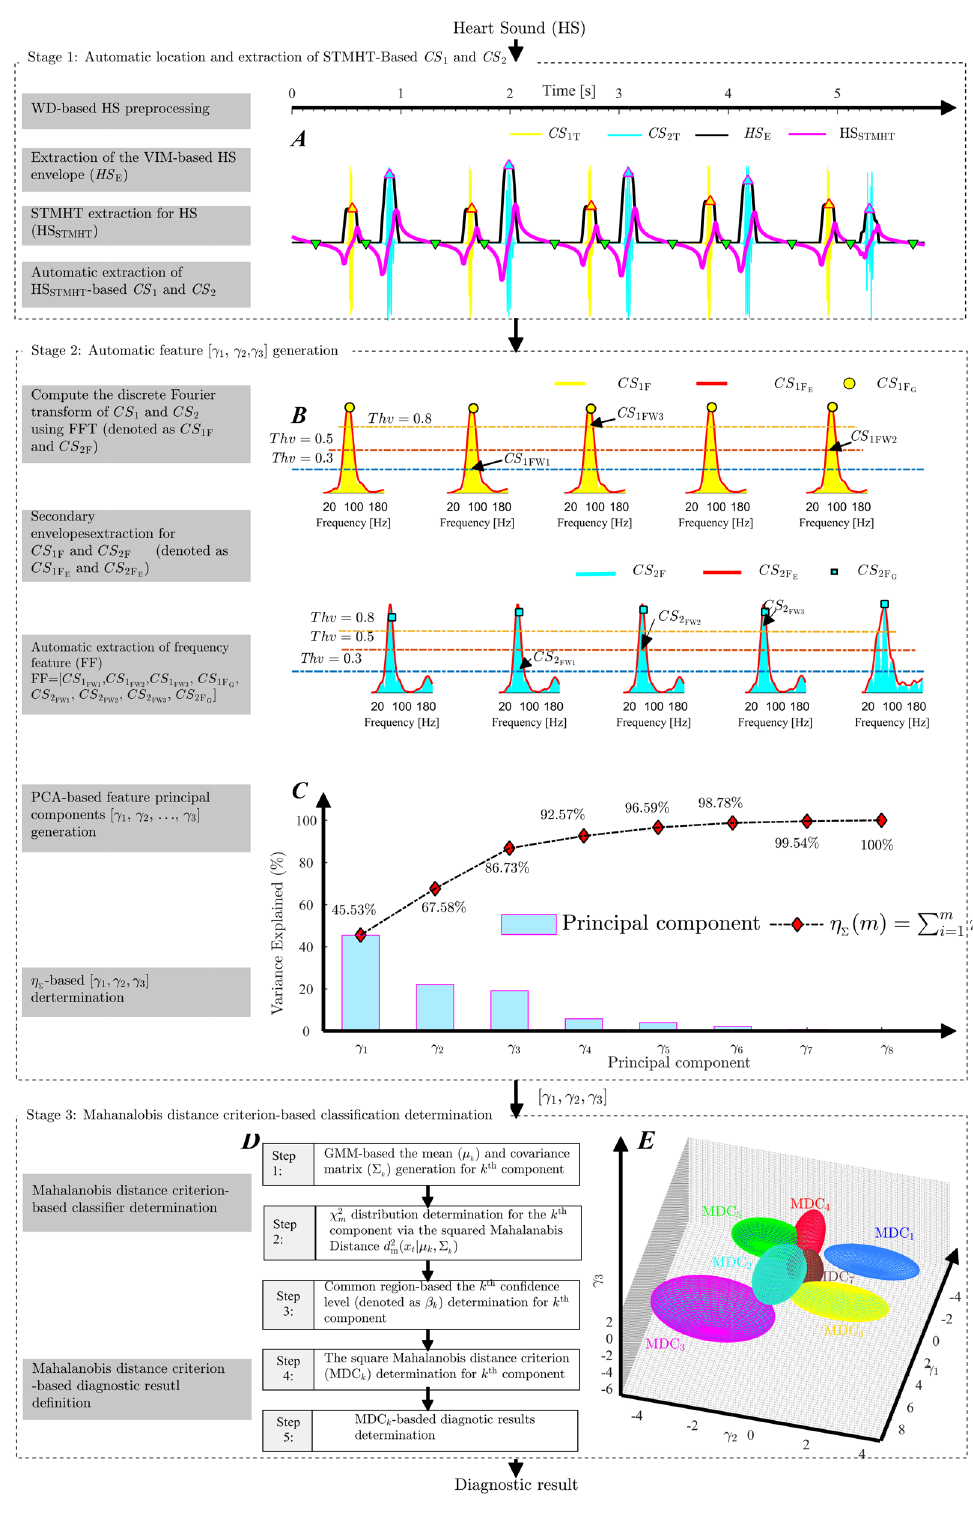
Figure 1. Flow chart of the proposed